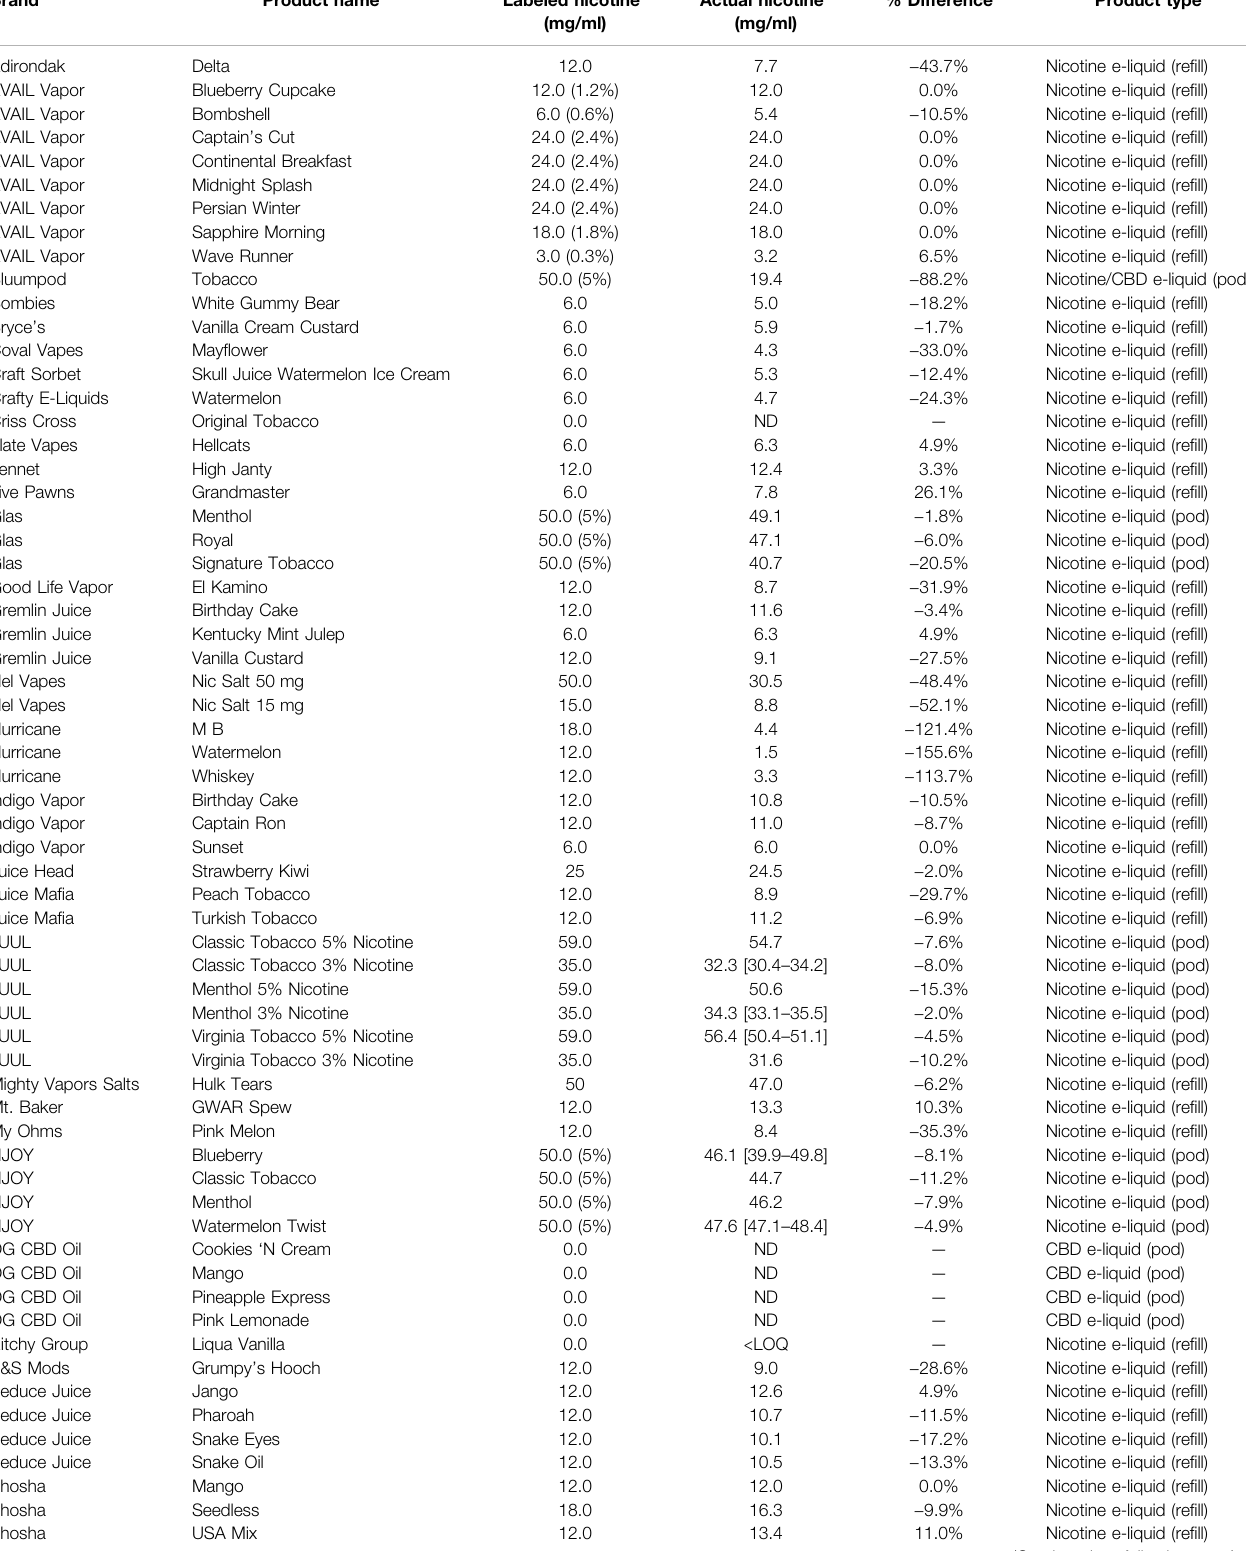
TABLE 2 | Actual nicotine concentrations in e-liquids vs. labeled concentrations.